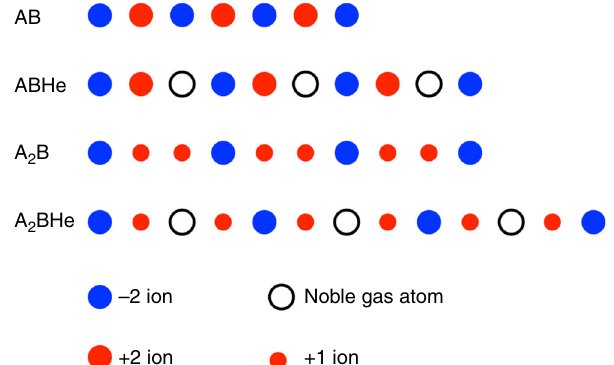
Fig. 4 One-dimensional schematics of He insertion in AB and A 2 B types of ionic compounds. The large red and blue fi lled circles represent the ions with + 2 and − 2 charges; the small red fi lled circles represent the ions with + 1 charge; the white circles represent the neutral